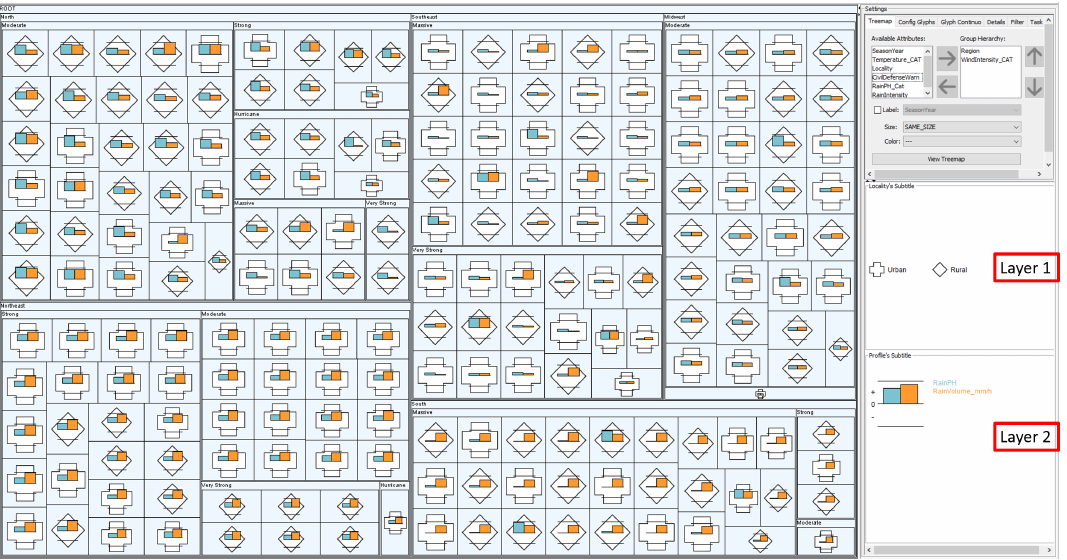
Figure 9. Scenario Glyphs and Hierarchy (GH) visualization configured for one of the user tasks. This visualization is a Treemap with hierarchy and